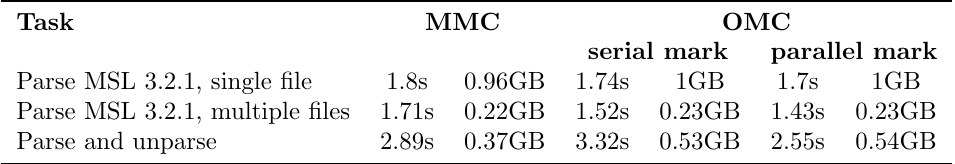
Table 3: Compiler performance,